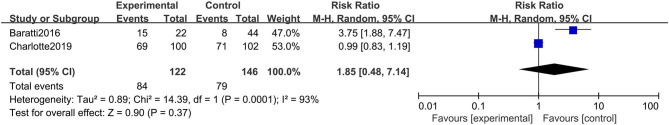
Forest plot of PFS comparing the experimental group to control group among CRC patients at high risk of PC.